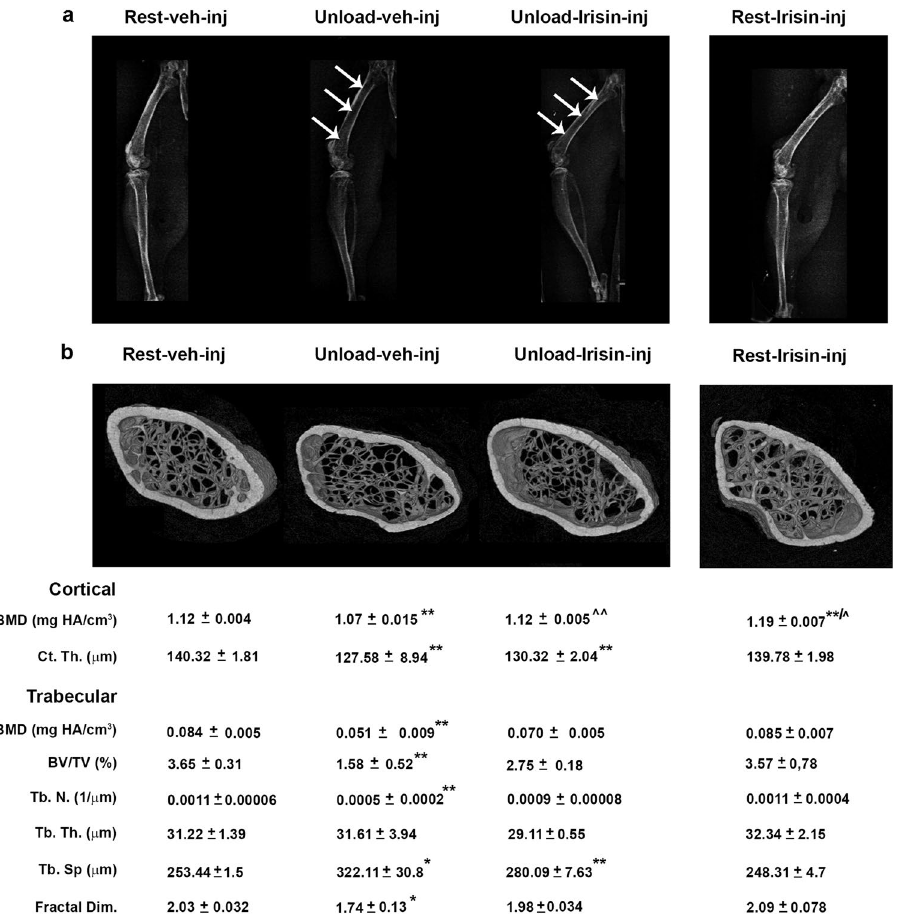
Figure 1. Treatment with r-Irisin prevents bone loss in femurs from hindlimb-suspended mice. ( a ) Contact radiographs of selected long bones from normal loading mice (Rest veh-inj) and unloaded mice treated with vehicle or recombinant Irisin (r-Irisin, 100 µ g kg − 1 per week for 28 days, mice were sacrificed 24 hours after last dose). Arrows indicate difference in radiodensity between femur of unloaded mice treated with vehicle and femur of unloaded mice treated with recombinant Irisin. ( b ) Representative micro-CT-generated section images and calculated cortical and trabecular parameters of femurs harvested from Rest mice vehicle- or Irisin- injected and Unload mice vehicle- or r-Irisin-injected. Cortical bone parameters included bone mineral density (BMD) and cortical thickness (Ct.Th). Trabecular bone parameters included bone mineral density (BMD), bone volume/total volume (BV/TV), trabecular number (Tb.N), trabecular thickness (Tb.Th), trabecular separation (Tb Sp) and Fractal Dimension. Data are presented as mean ± SEM. n = 7–8 mice per group. All data were normally distributed according to the Shapiro-Wilk normality test and analyzed by one-way ANOVA and Bonferroni’s post hoc analysis. Cohen’s d values were measured for non-significant differences of results and can be found as Supplementary Table S1. * p ≤ 0.05, ** p ≤ 0.01 versus Rest vehicle-injected mice. ^ p ≤ 0.05, ^^ p ≤ 0.01 versus Unload vehicle-injected